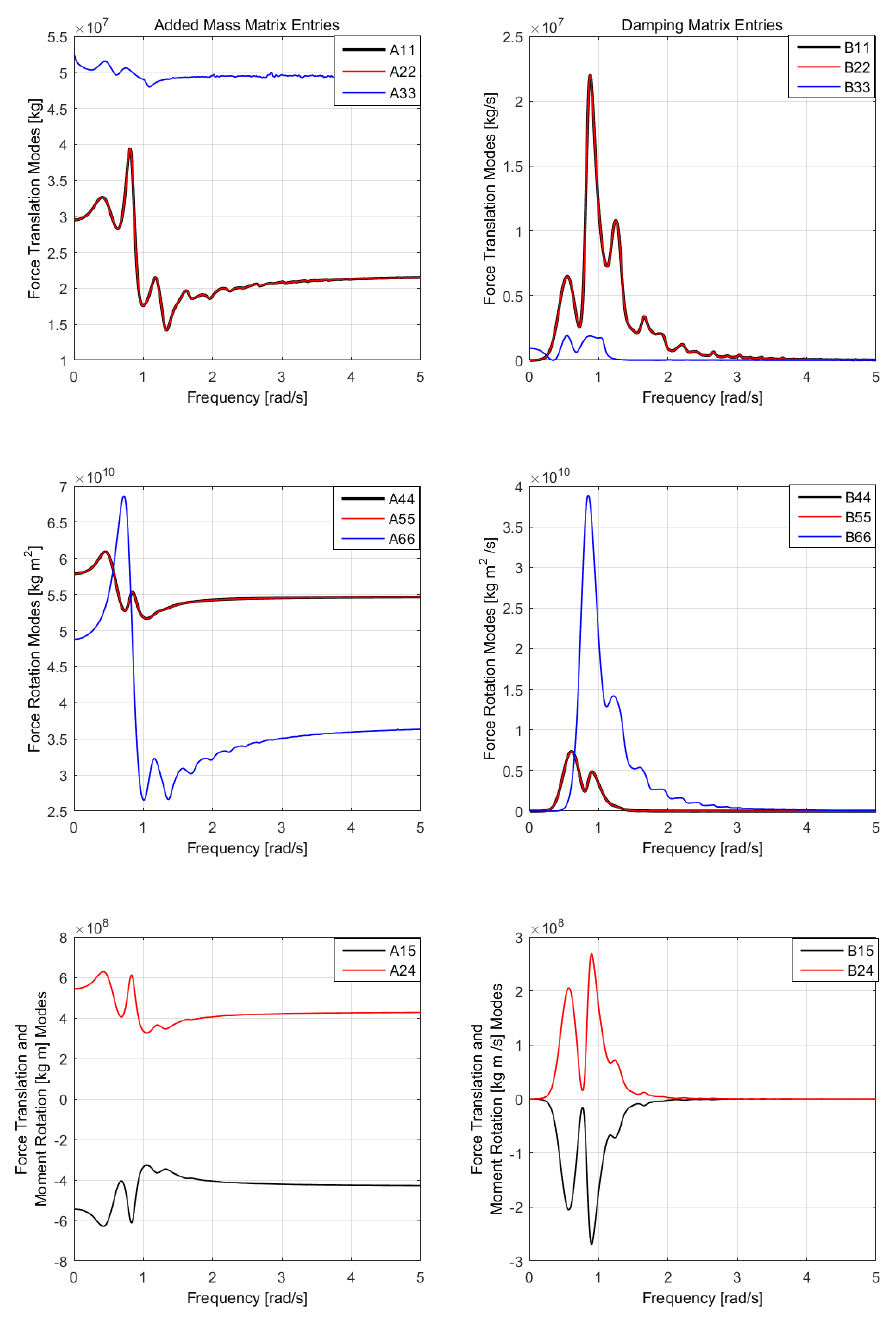
Figure 9. SNL semi-submersible platform added mass and radiation damping coefficients for a zero wave